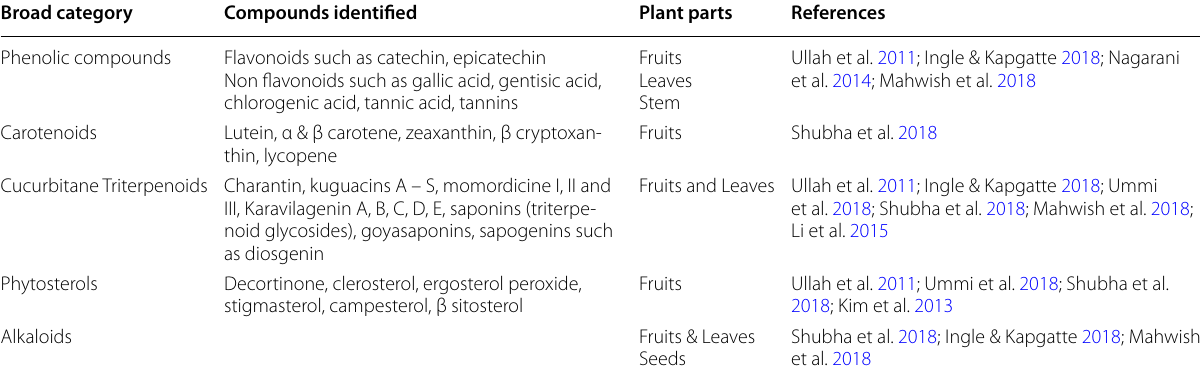
Table 3 List of different bioactive compounds identified from different parts of bitter gourd plant Broad